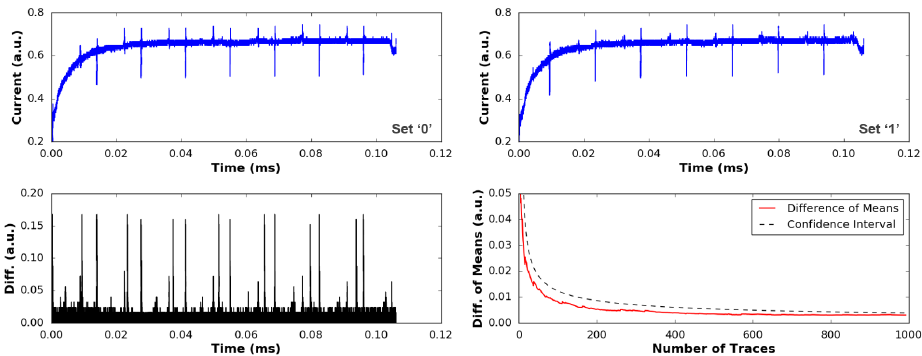
Figure 17: Difference-of-means test for polynomial coefficient-wise multiplication with representative power traces from set S 0 (top left) and S 1 (top right), difference waveform (bottom left) and difference of means versus number of traces with 99.99% confidence interval (bottom right).